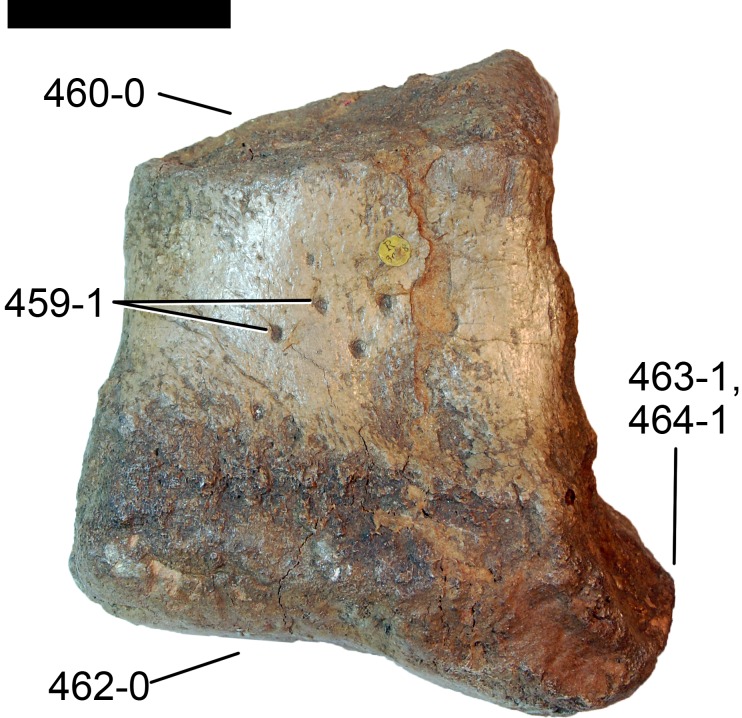
Metatarsal I of Cetiosauriscus stewarti NHMUK R3078 in dorsal/anterior view.Note the foramina (C459-1), the angled proximal (C460-0) and distal articular surfaces (C462-0), and the distinct posterolateral process on the distal articular surface (C463-1, C464-1). Scale bar = 5 cm.